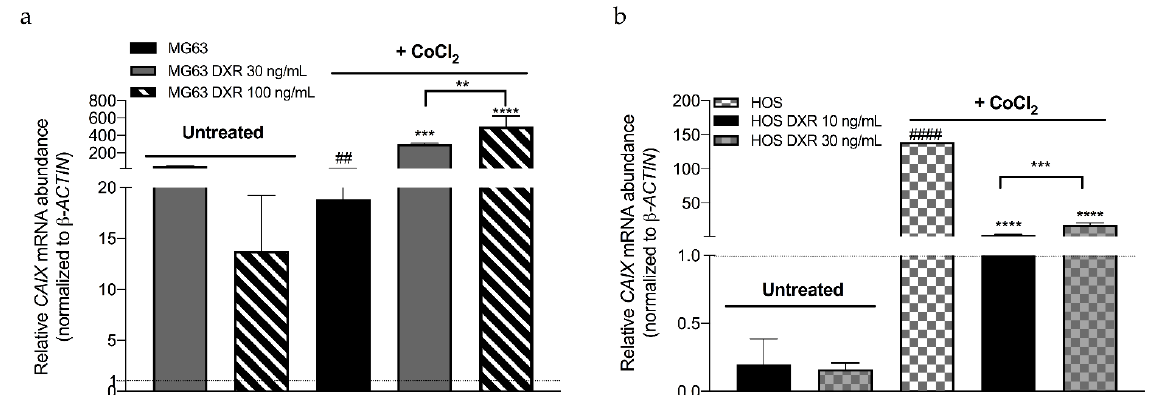
Figure A1. ( a ) Relative mRNA expression levels of CAIX gene in MG63, MG63 DXR 30 ng/mL, and MG63 DXR 100 ng/mL cells following treatment with CoCl 2 . mRNA levels of CAIX are normalized to